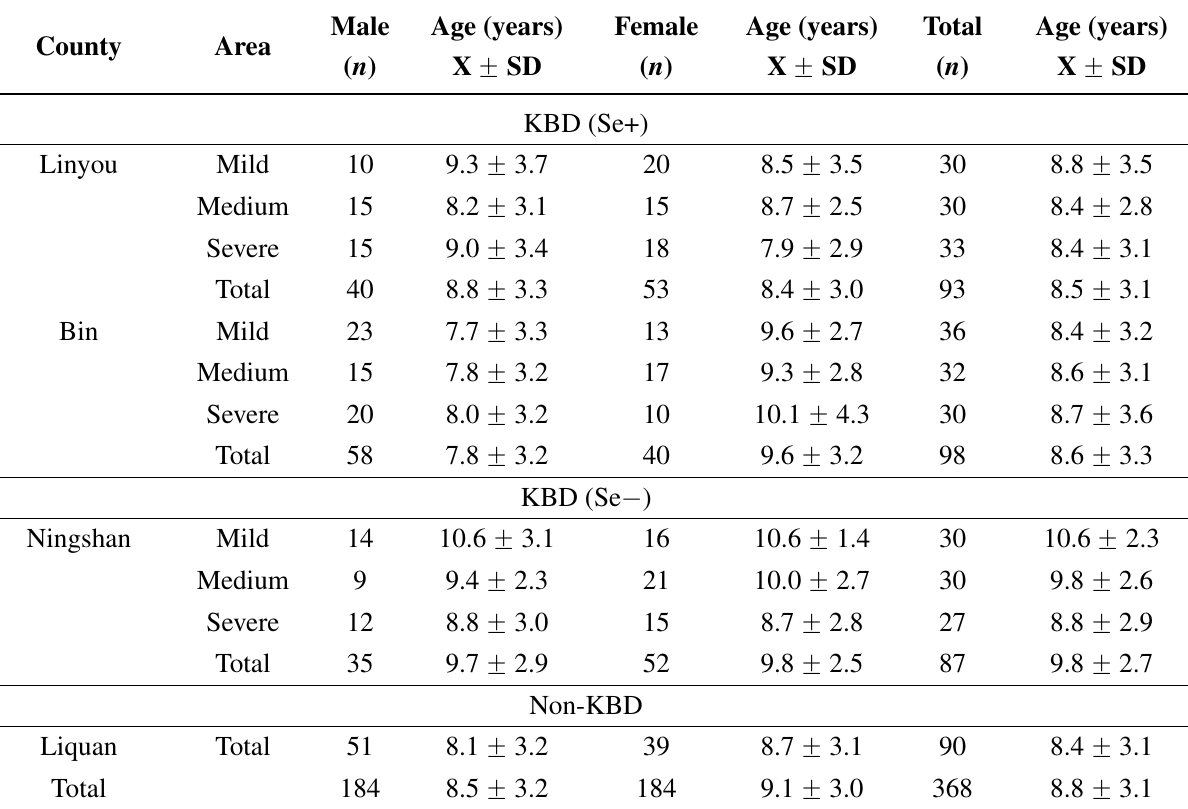
Table 2. Description of gender ratio and average age of children in this